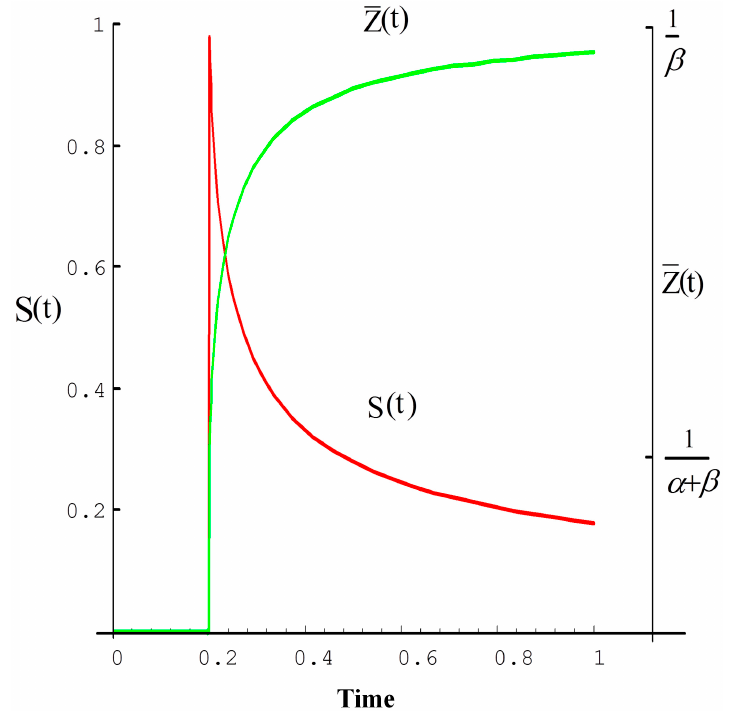
Figure 2. The OTTER signal and its average radiation depth, left Y axis is the normalized signal intensity, right Y axis is the mean detection depth, and X axis is normalized time [10].